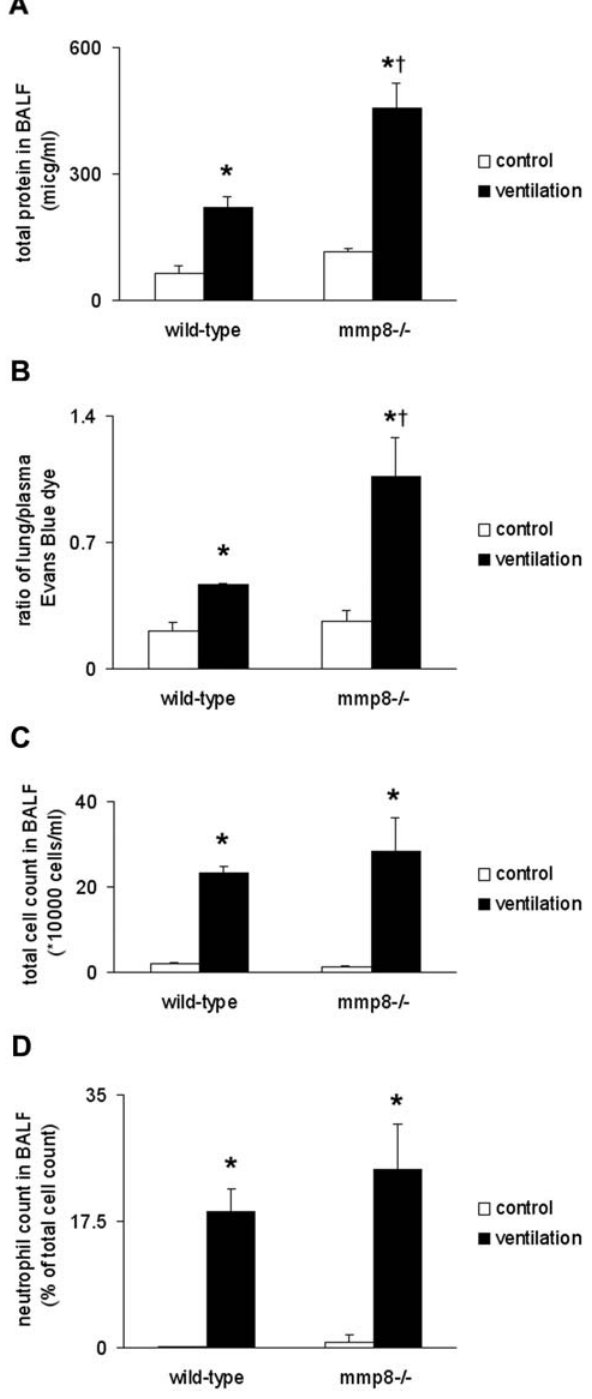
Figure 11. Indirect lung injury indices of mice deficient in mmp8. (A) Total protein levels were significantly higher in mmp8 2 / 2 mice than in wild-type mice following mechanical ventilation (10 ml/kg, 8 hours). (B) Microvascular permeability, assessed with EB dye extravasation was significantly higher in mmp8 2 / 2 mice than in wild- type mice following mechanical ventilation. (C) Total cell counts were not modified by MMP8. (D) MMP8 did not affect neutrophil recruitment to the lung at 8 hours. *represents significant differences between control and ventilated animals, { represents significant differences between wild-type and mmp8 2 / 2